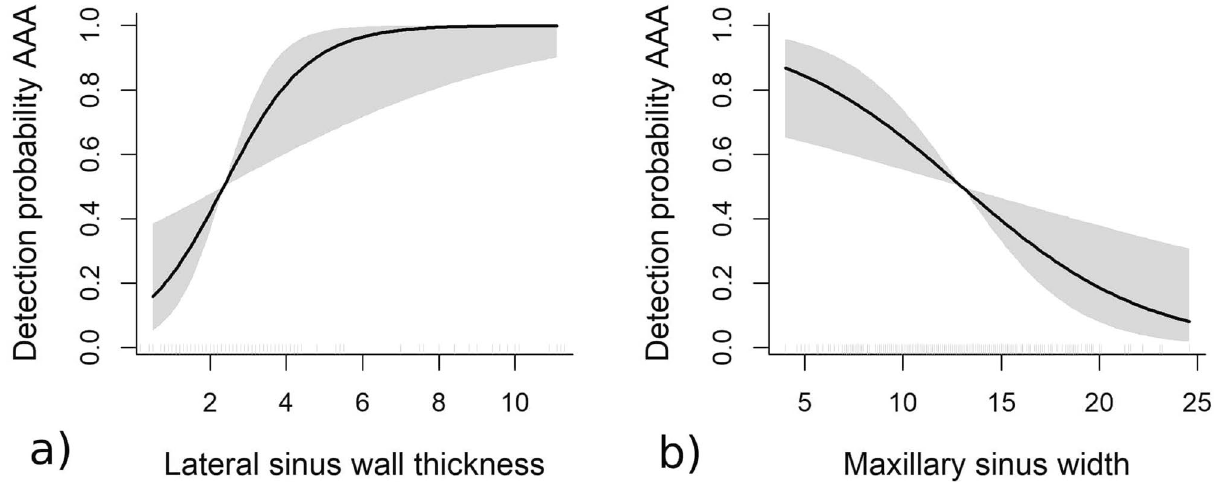
Figure 2. Detection probability for male patients (shaded grey area representing 95% point-wise confidence band). ( a ) Effect of lateral sinus wall thickness on detection probability AAA; ( b ) Effect of maxillary sinus width on detection probability